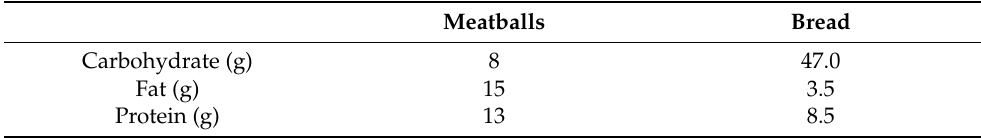
Table 2. Nutritional composition of lunch meal per 100 g 1 .